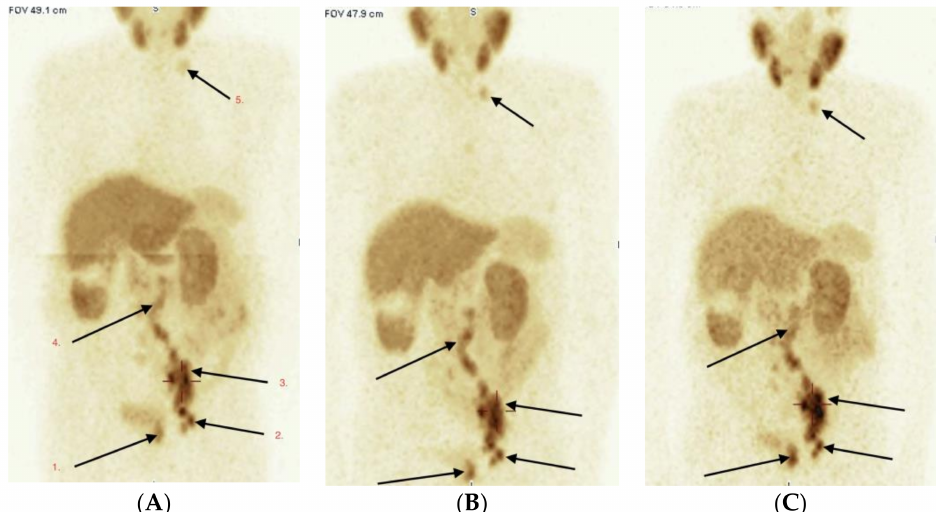
Figure 3. ( A – C ) Male 87 year, adenoca G3; GlS = 8 (4 + 4). PSA 228.0 ng/mL. Evaluation of tumor extent. Three scans of WB-SPECT/CT acquisition after 1 h ( A ), 3 h ( B ) and 6 h ( C ) after radio-tracer i.v. administration. Pathological high uptake of [99mTc]Tc-PSMA-T4 is seen in primary PCa—left lobe of prostate (1), multiple lymph nodes: left obturator (2), left external and common iliac (3), paraaortic left and right (4) and the left neck (5). No bone lesions were detected in current PSMA, bone and CT